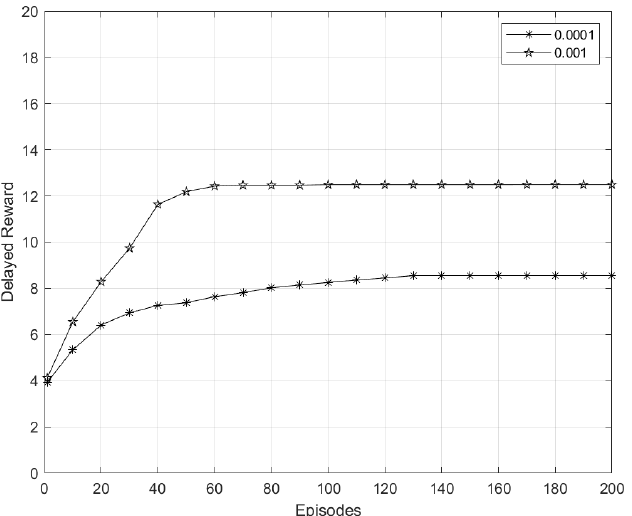
Figure 8. Convergence of the DQN algorithm with different learning rates. A higher learning rate α shows a faster convergence as compare to a lower learning rate α